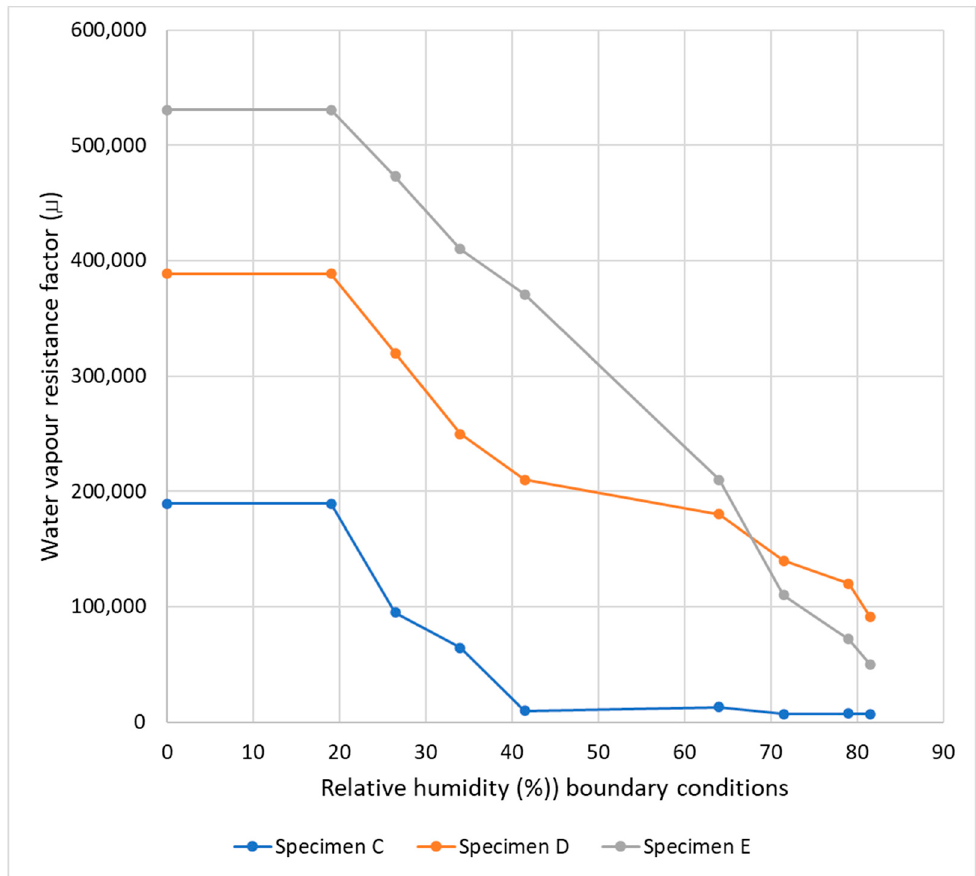
Figure 7. Final plot of the resistance factor µ against boundary conditions after harmonic curve adjustment for specimen C.